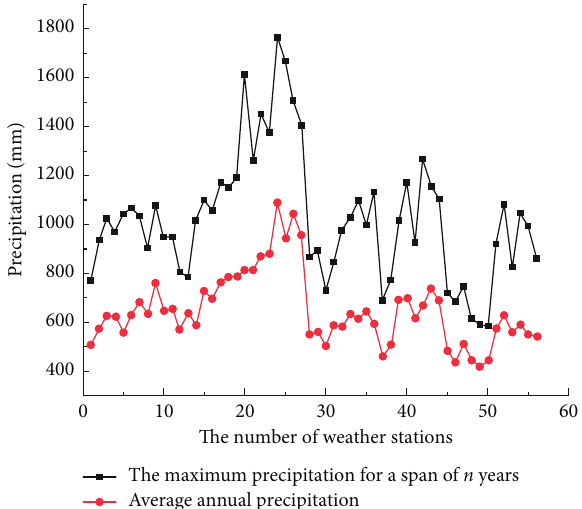
Figure 6: Main climate variables of precipitation.